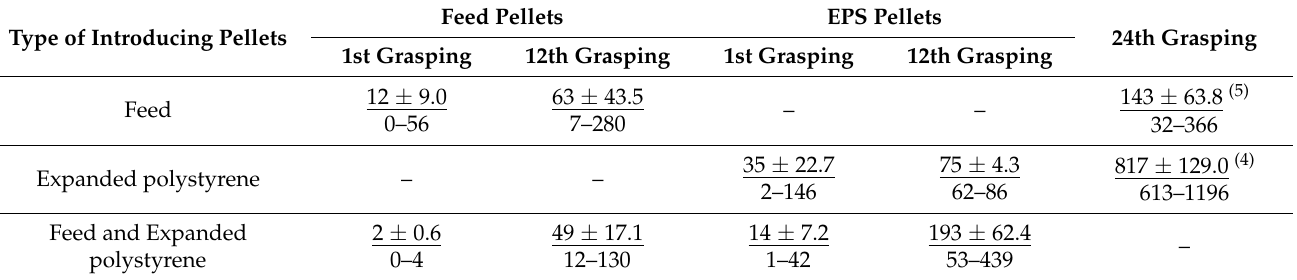
Table 2. The time of grasping feed and EPS pellets by Anabas testudineus during 20 min. Type of Introducing